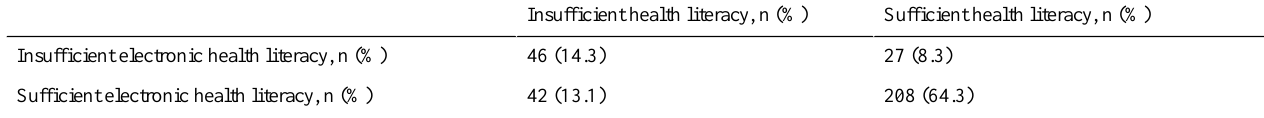
Table 5. Distribution of participants scoring insufficient and sufficient health literacy and eHealth